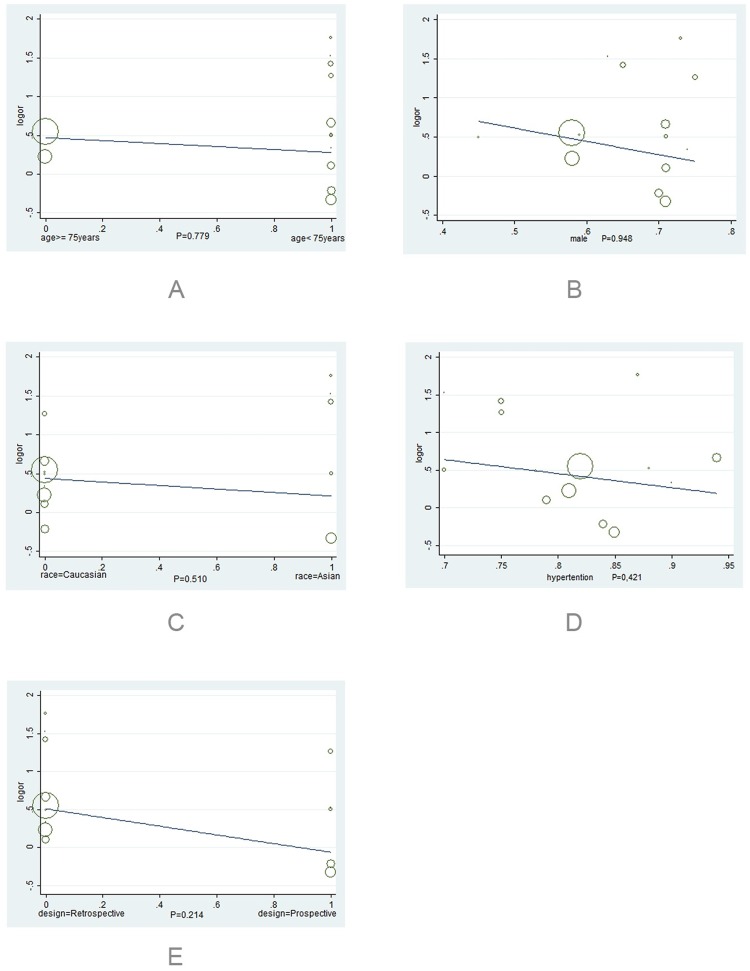
Scatter plots of univariate regression analysis in major bleeding.(A) The proportion of age (<75 years, ≥75 years); (B) Male proportion; (C) The proportion of race (Caucasian and Asian); (D) Hypertension patient proportion; (E) study design (retrospective and prospective).